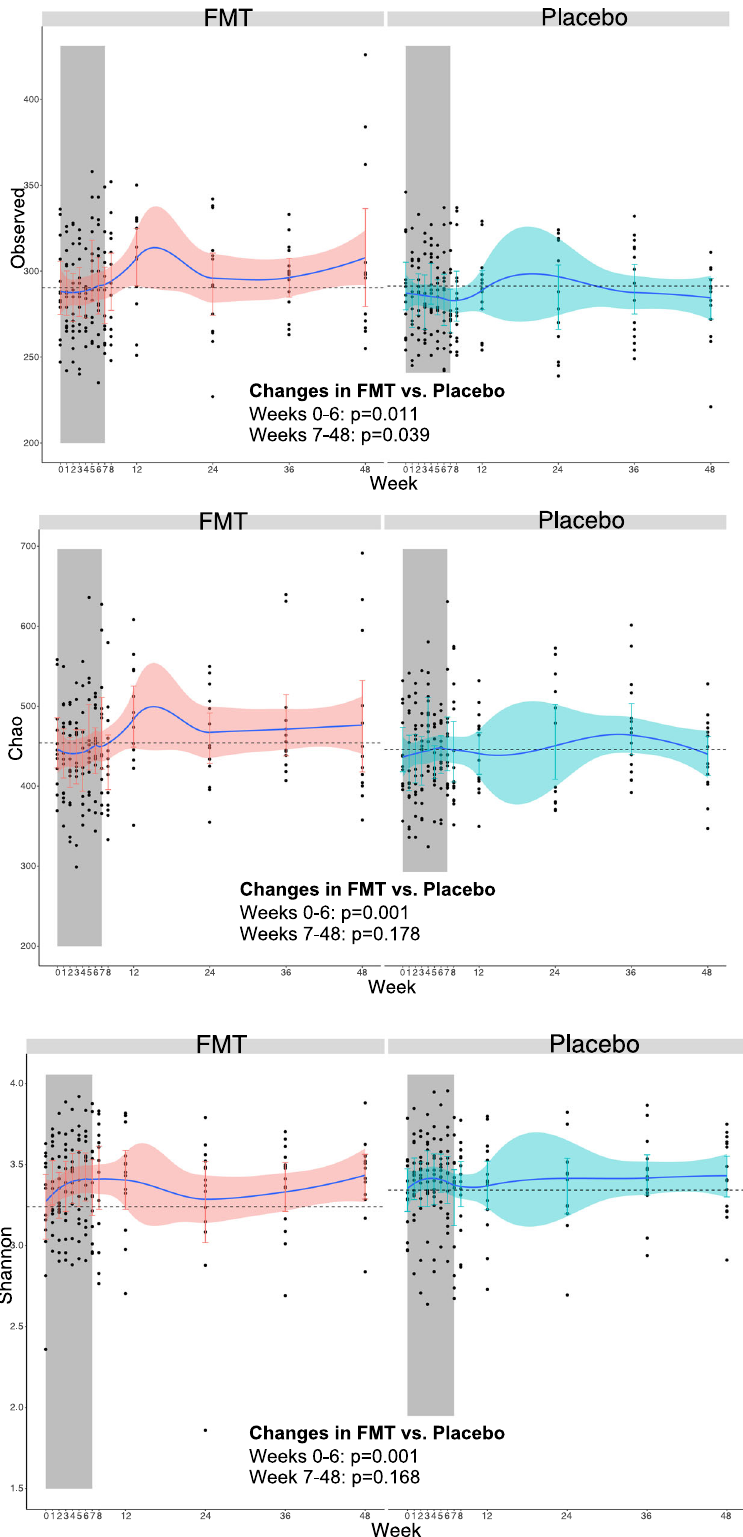
Fig. 1 Changes in three metrics of alpha diversity at the OTUs level in each the FMT (red) and placebo (blue) groups. Bacterial richness (number of OTU), Chao1 and Shannon indexes increased incrementally in the FMT arm. Black dots represent individual measurements. Blue lines represent the smoothed mean value. Horizontal dashed lines represent the baseline levels. Vertical bars represent the 95% con fi dence intervals. The gray area indicates the induction period in which study participants received FMT or placebo. Two-sided P values estimated using mixed models not adjusted for multiple comparisons remained unchanged after adjustment for nadir CD4 and time since HIV diagnosis. Abbreviatures: FMT, fecal microbiota transplant. n = 361 biologically independent samples from 14 individuals in the FMT group and 15 individuals in the placebo